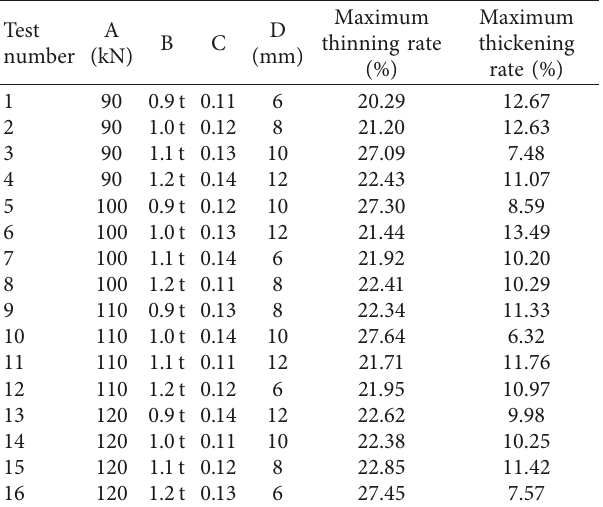
Table 3: Experimental data table of forward intersection of fender. Test